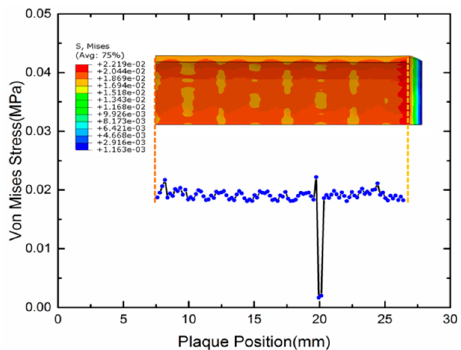
Figure 9. Von Mises stress contours of the plaque along the stent length.